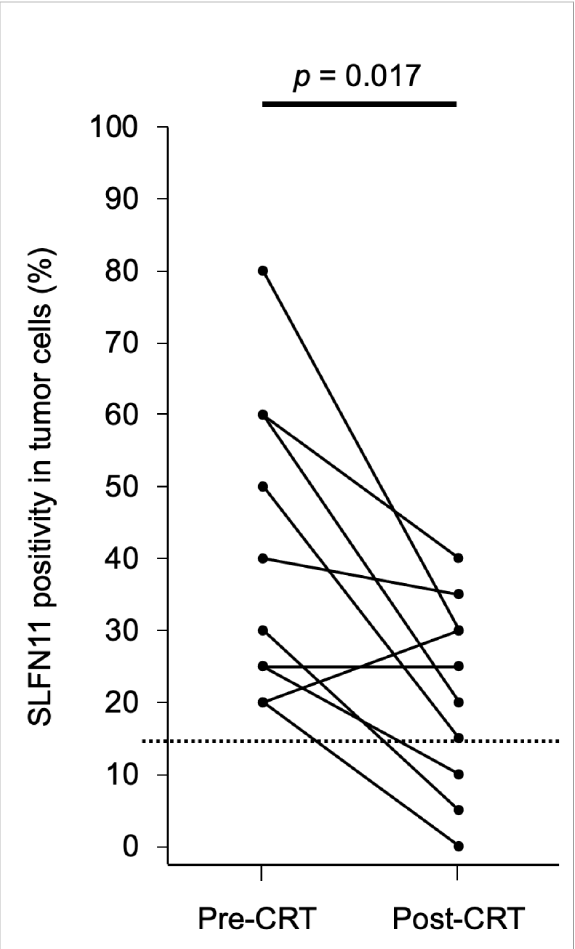
FIGURE 3 Percentage of SLFN11 positivity in tumor cells before and after CRT. SLFN11 expression in tumors before CRT and in residual or recurrent tumors with local failure after CRT is plotted for 10 paired samples. The dashed line represents the threshold value (15%) used for de fi ning SLFN11-positive samples. Data were analyzed using the Wilcoxon signed-rank